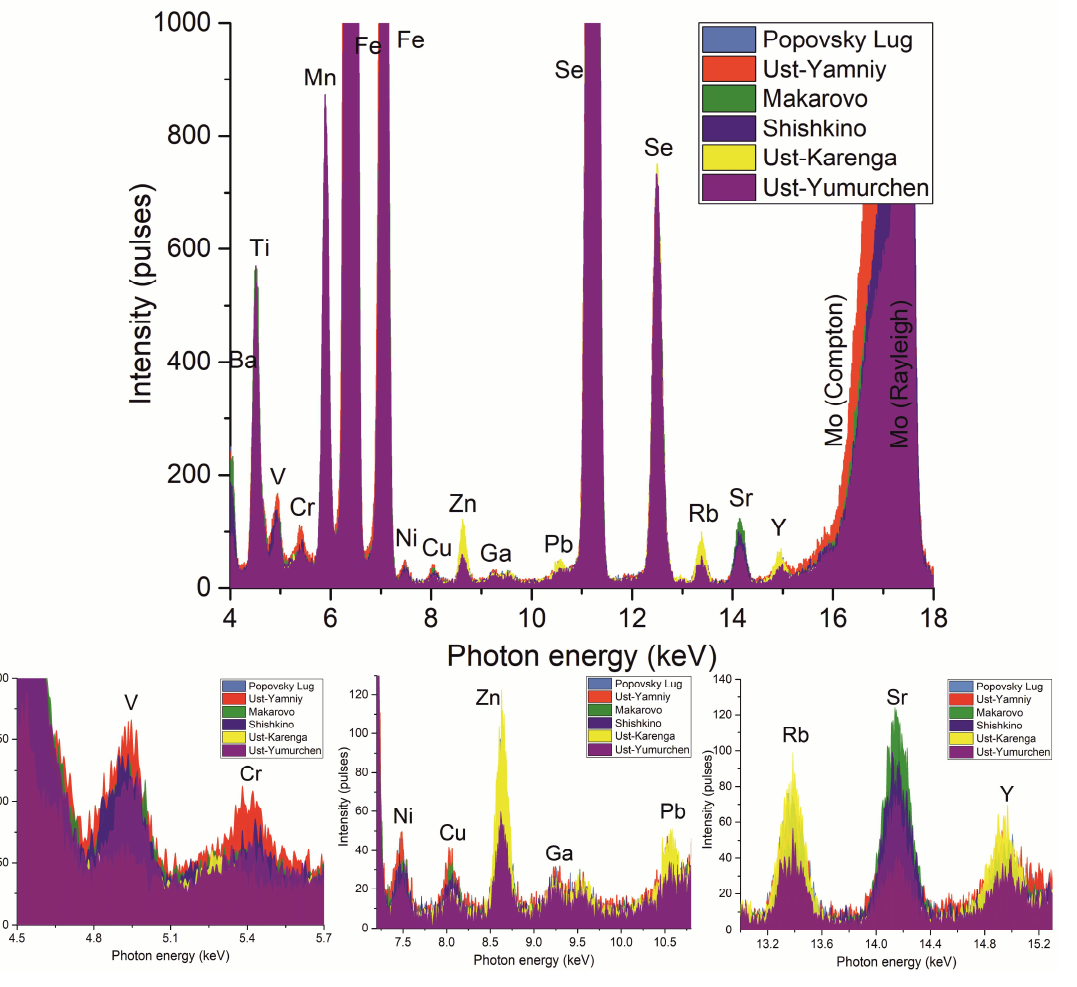
Figure 1. TXRF spectra (energy range: 4.0–18 keV) of ceramic samples, one of each from different archaeological sites.